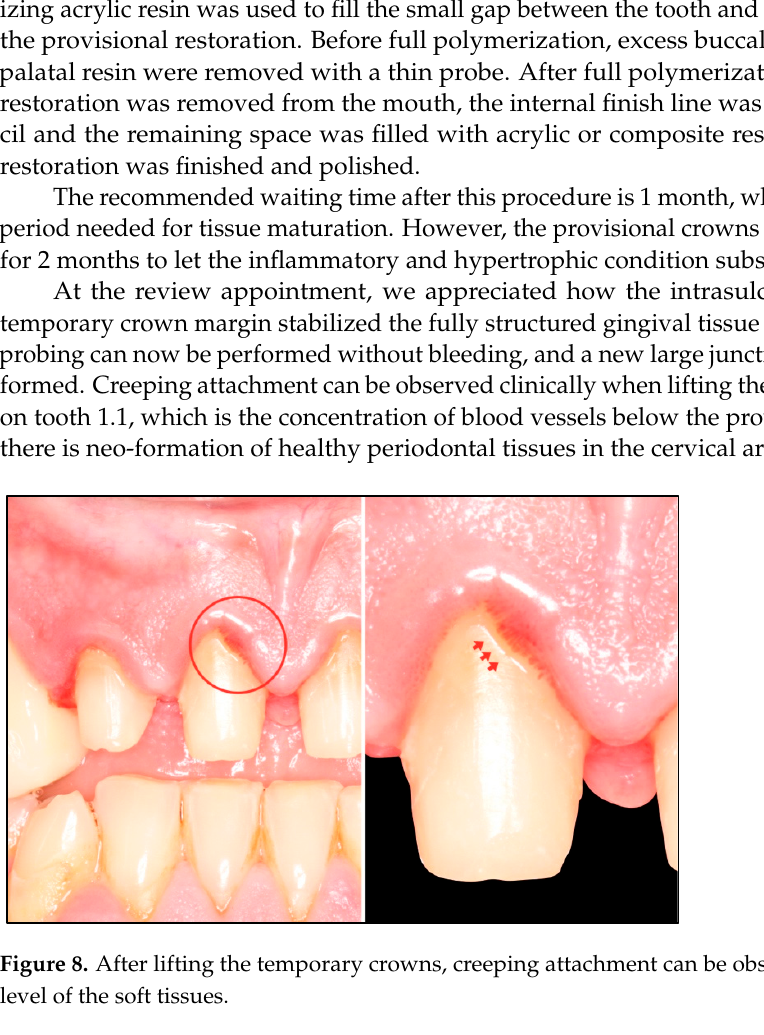
Figure 8. After lifting the temporary crowns, creeping attachment can be observed at the marginal level of the soft tissues.